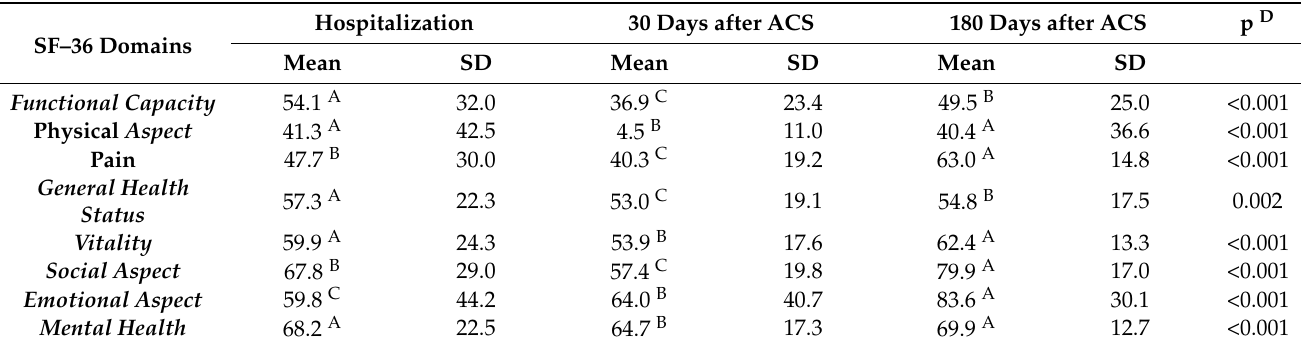
Table 2. Quality of life, according to SF–36 domains in patients from public and private health care systems who presented with ACS , Aracaju, Brazil.